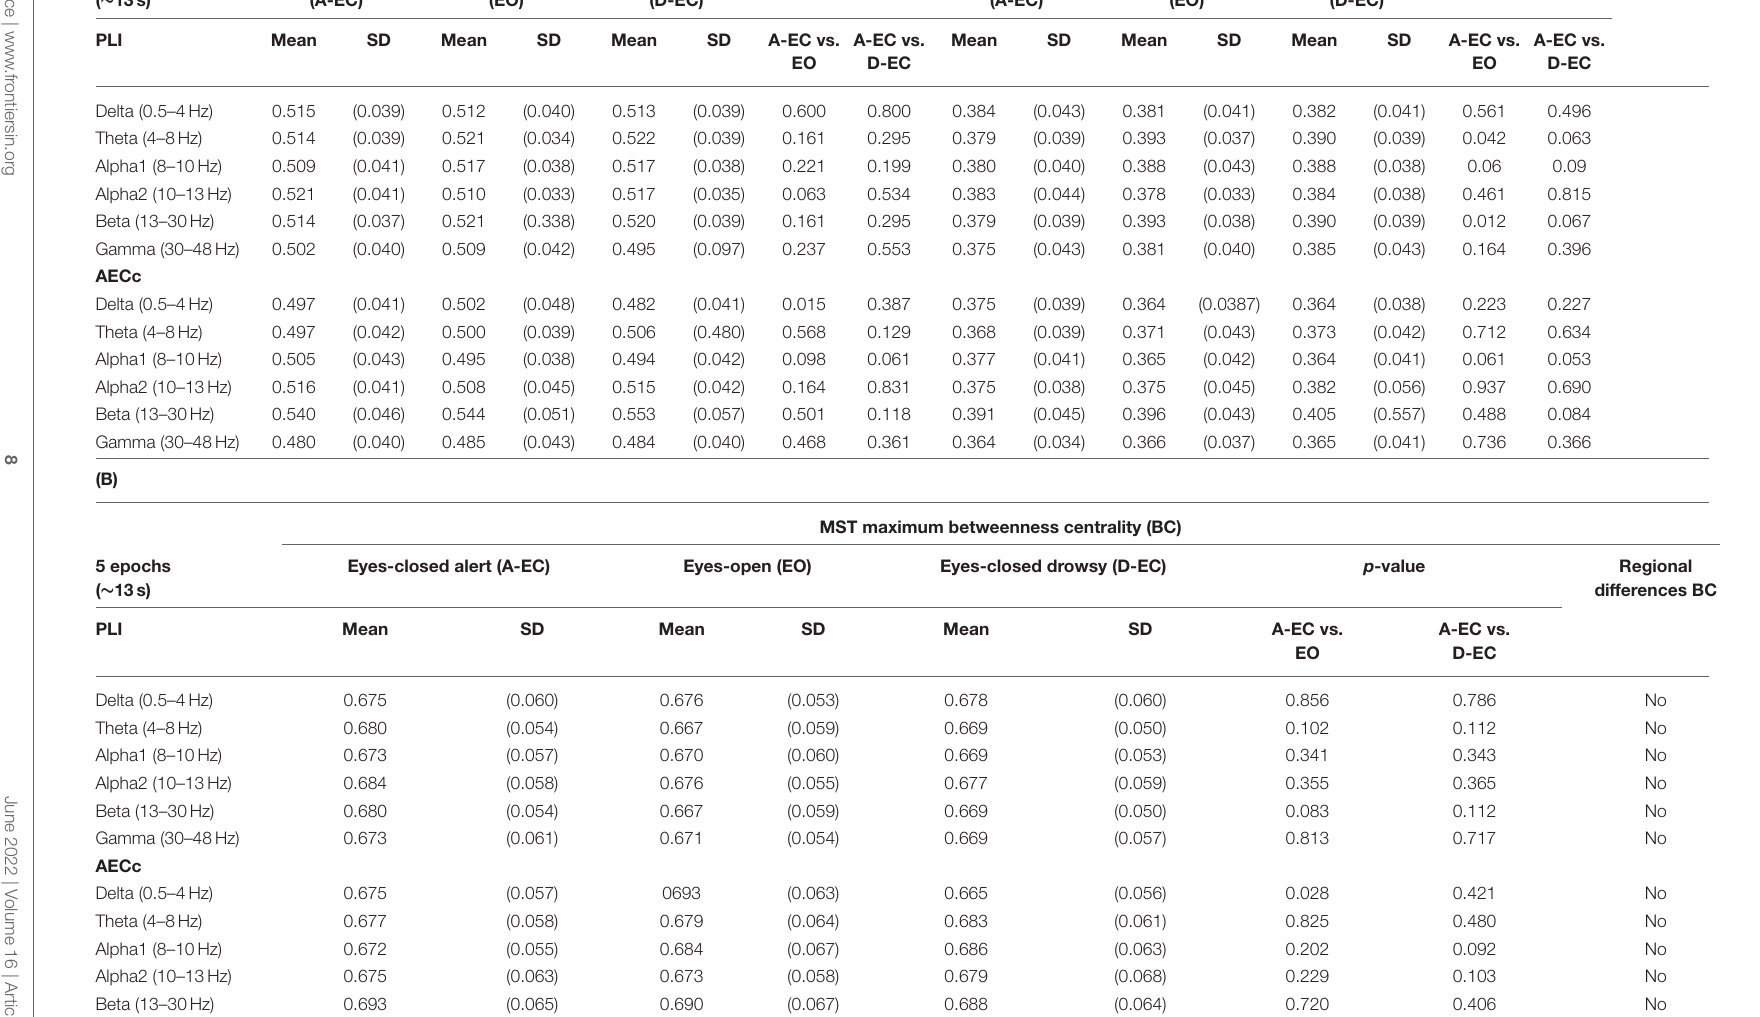
TABLE 2 | Network analyses (using the minimum spanning tree (MST) in all frequency bands for the eyes-closed alert (A-EC) and drowsy states (D-EC), and eyes-open (EO) condition for 19 subjects with 5 epochs (epoch length of 13.1072s) for each of the states or conditions. (A) MST Leaf fraction (LF) MST Tree hierarchy (TH)